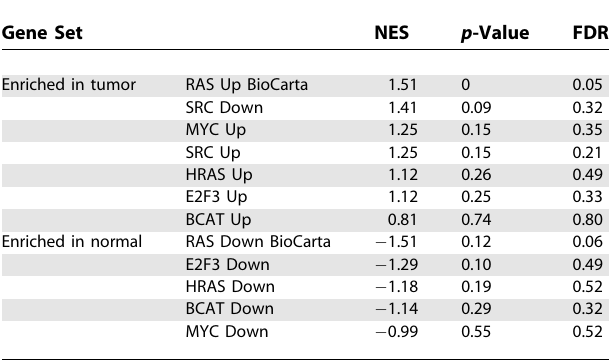
Table 4. GSEA Results for the Oncogenic Gene Sets Defined [24] and BioCarta in the KRAS Mutant/Normal Dataset Gene Set NES FDR Enriched in